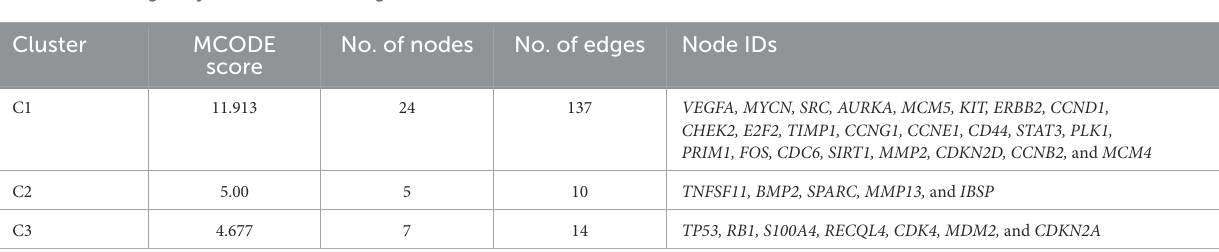
TABLE 3 Clustering analysis of Osteosarcoma gene interaction